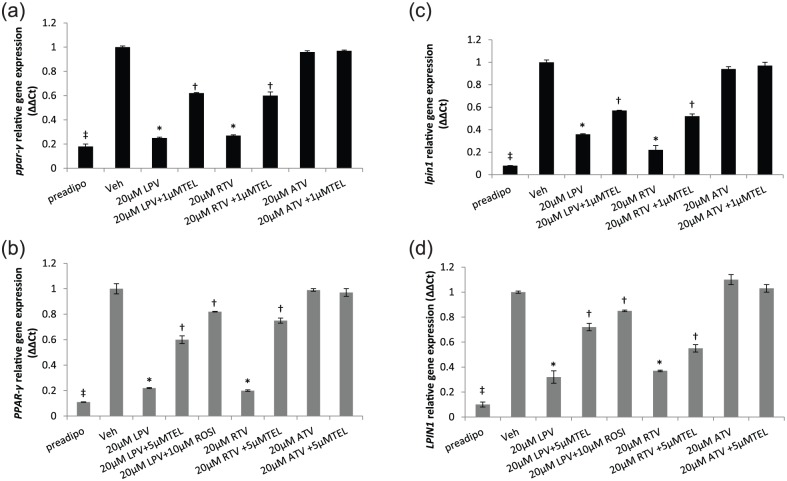
Expression of PPARγ: (a) 3T3-F442A and (b) primary human adipocytes;
expression of LPIN1: (c) 3T3-F442A and (d) primary human adipocytes,
following incubation with PIs with/without TEL or ROSI. ROSI was
coincubated with LPV in the primary human adipocyte model only. Data
are expressed as mean (n = 3) ± SD.
(*p < 0.01, drug vs vehicle;
†p < 0.01, drug vs drug + TEL or
drug + ROSI; ‡p < 0.01, preadipocyte
vs vehicle.).Preadipo: preadipocyte; Veh: vehicle; RTV: ritonavir; LPV: lopinavir;
ATV: atazanavir; TEL: telmisartan; ROSI: rosiglitazone.